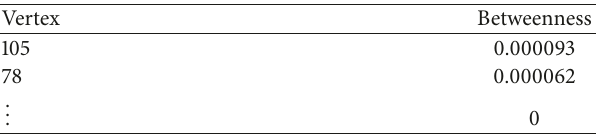
Table 5: Betweenness in CMRN.